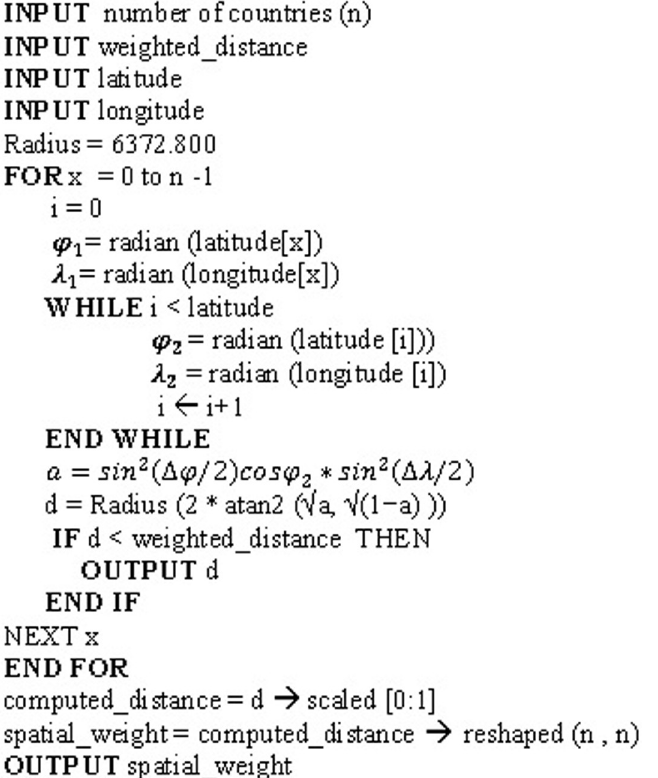
Fig 7. Algorithm 1. Initializing the adjusted spatially-weighted adjacency